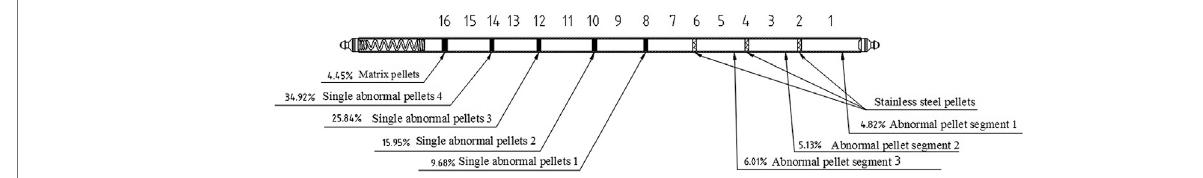
FIGURE 2 | Integral enrichment standard rod.